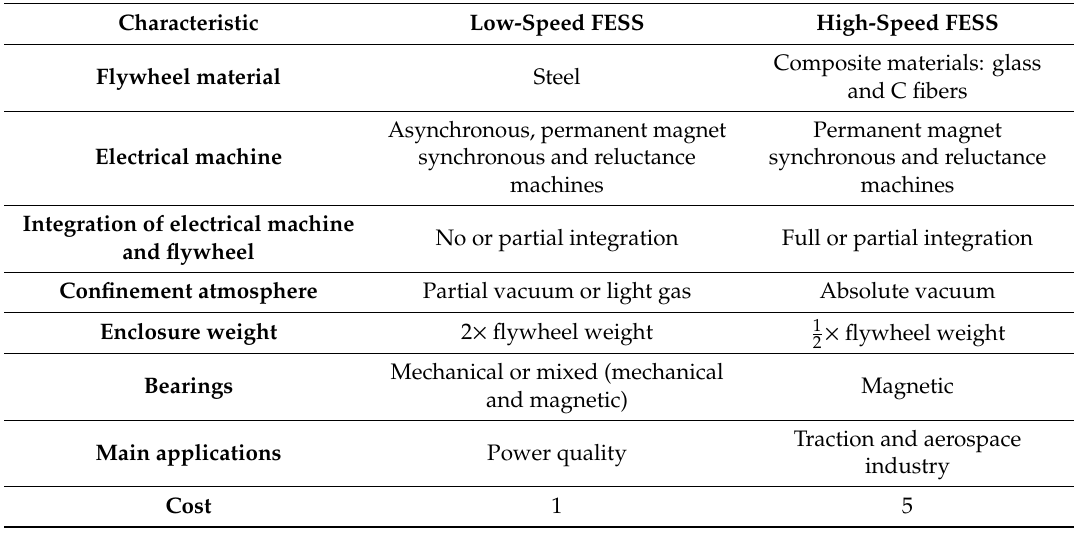
Table 4. Comparison among the characteristics of low-speed and high-speed flywheel energy storage system (FESS)